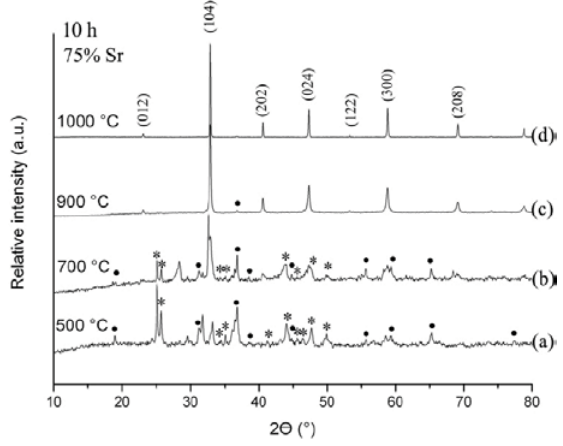
ics prepared at different temperatures: (a) 500°C, (b) 700°C, (c) 900°C, (d) 1000°C. Annealing time was 3 h. The Miller indices of LaCoO rity phases: • - Co